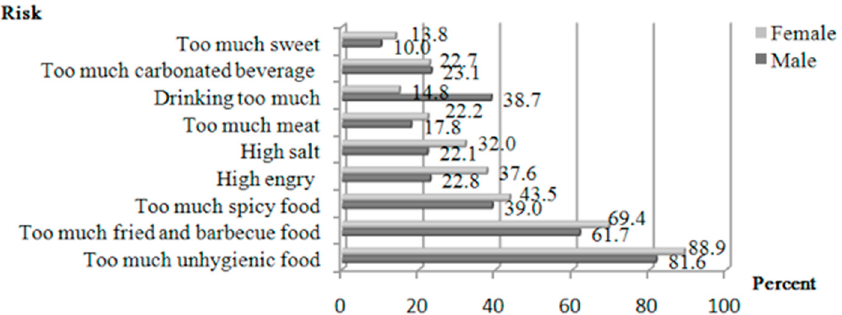
Figure 2. The potential risks of eating out for a long time.